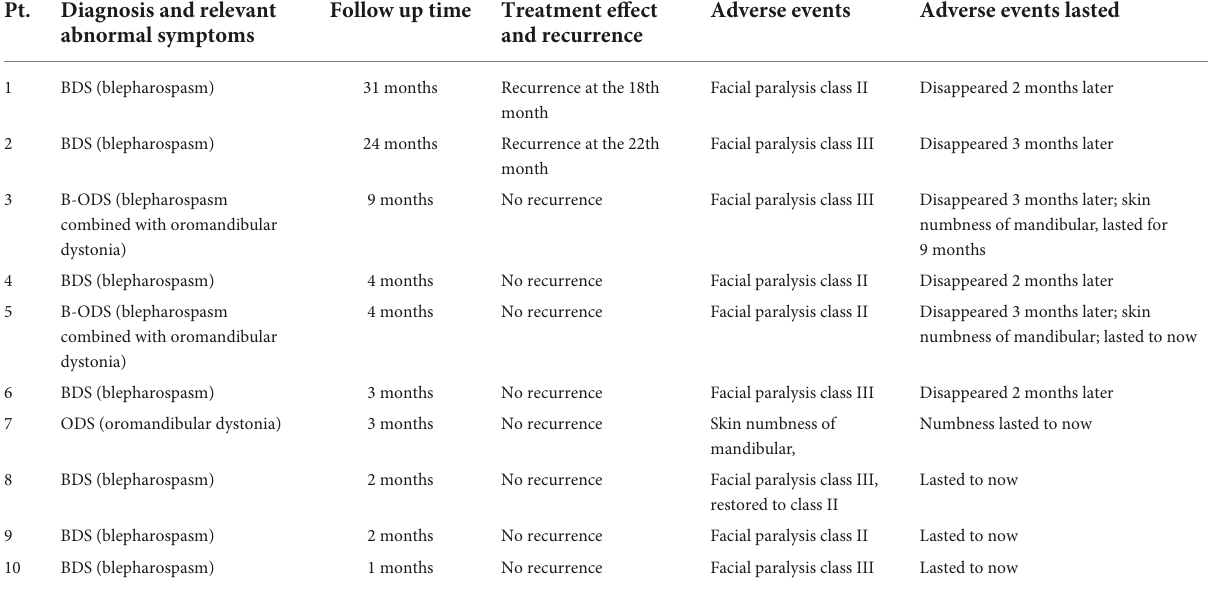
TABLE 2 The outcomes and adverse events of radiofrequency ablation for Meige’s syndrome.